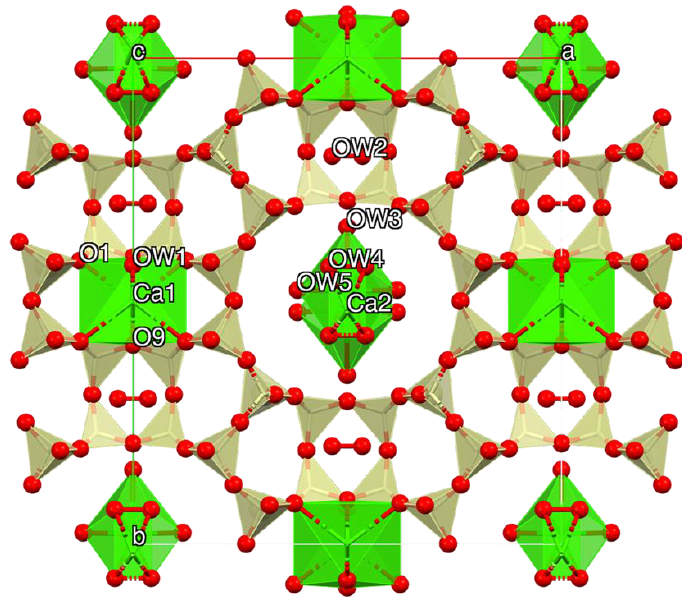
Figure 3. Sketch of the refined structure of SP1 as seen along [001]. Table 8. Relevant bond distances (Å ). The Al population at the various tetrahedral sites T (% Al) and the corresponding R = Si/(Si+Al) were calculated using the equation of Jones [82]. Data of Mortier et al. [81] are reported for comparison (M76). Due to short OW4 – OW4 contacts, only half of the Ca2 – OW4 distances are effectively occurring.